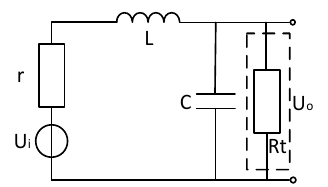
Figure 1. Air-coil sensor equivalent circuit.